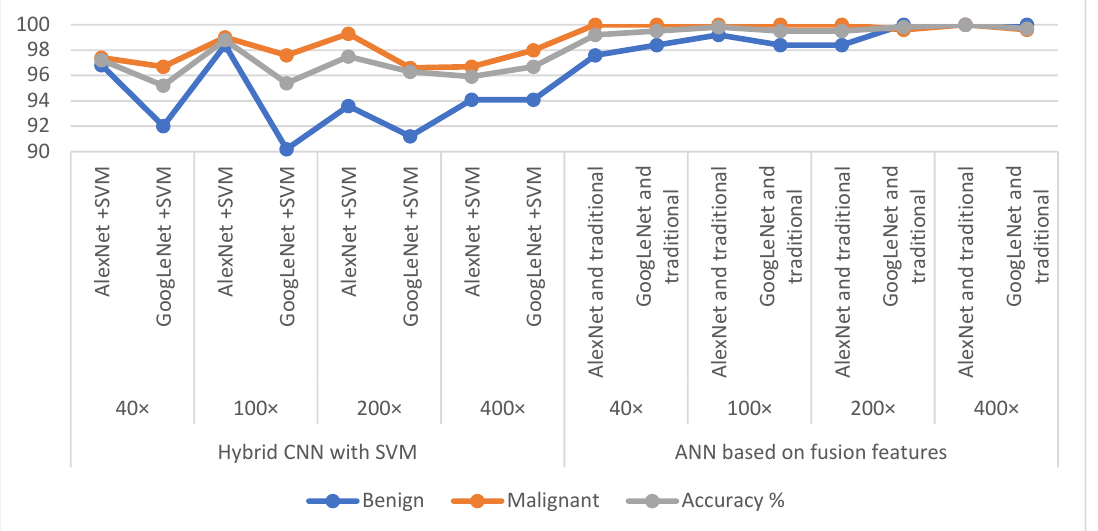
Figure 15. Diagnostic accuracy of HI of a BC dataset with all magnifications.